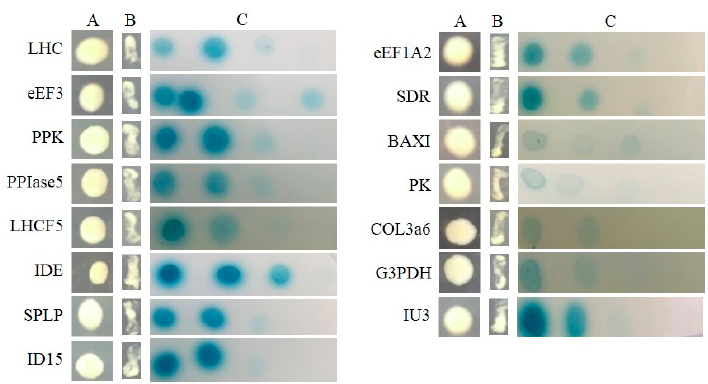
Figure 4. Plasmid linkage assays for WL transformants identified during yeast two-hybrid screening. Transformants containing the bait and prey plasmids were identified based on their growth on dropout medium (SD -Leu-Trp ; column A). Putative interacting partners were identified based on their growth on SD -Leu-Trp-His-Ade (column B), and the interaction strength was detected based on the growth on SD -Leu-Trp-His-Ade medium with α -x-gal (column C), each drop concentration ranged from 10 − 1 , 10 − 2 , 10 − 3 to 10 − 4 .